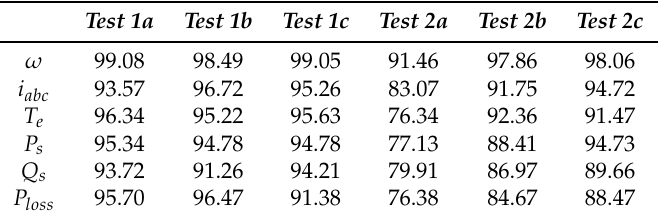
Table 3. Fidelity measures for the DFIG.